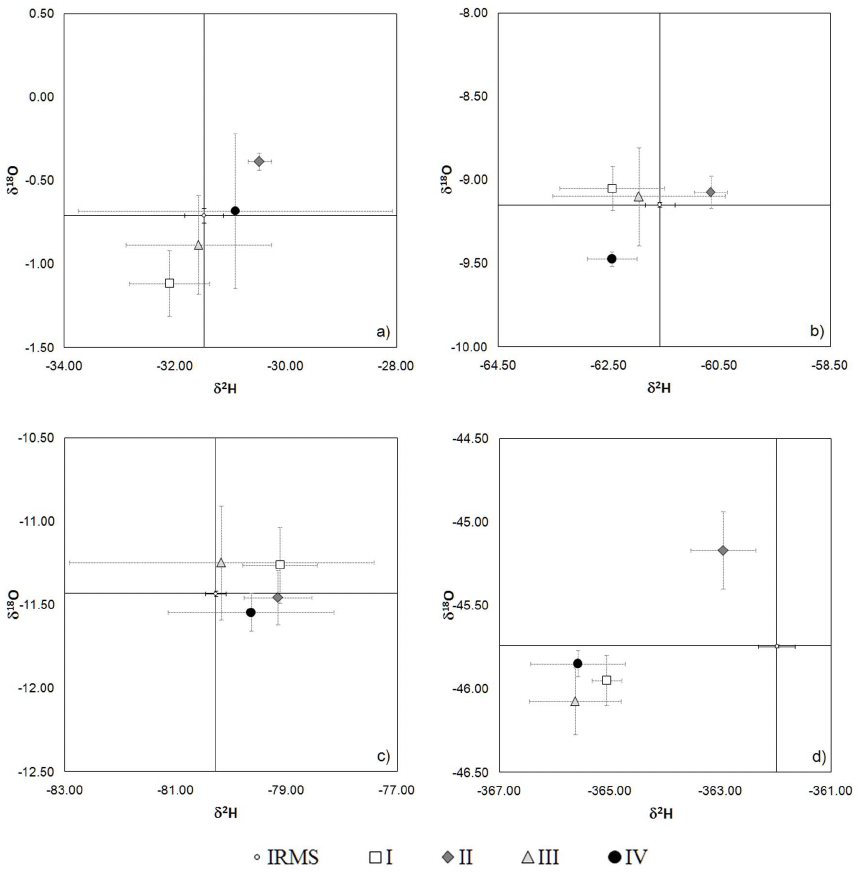
Fig. 5. Overall accuracy and precision of laser spectroscope measurements compared with the mass spectrometer for a range of isotopic values (A1 scheme). Samples: (a) 29; (b) 25; (c) 8; (d)